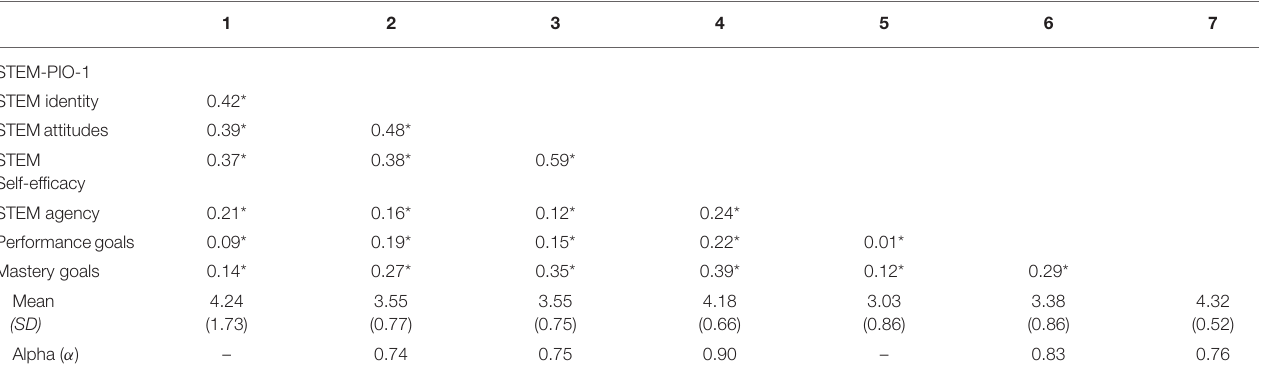
TABLE 2 | Descriptive statistics for measured variables in study